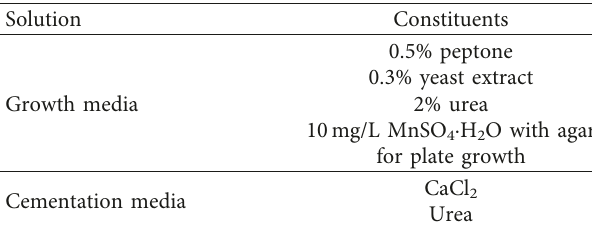
Table 1: Summary of the microbial-induced carbonate pre- cipitation